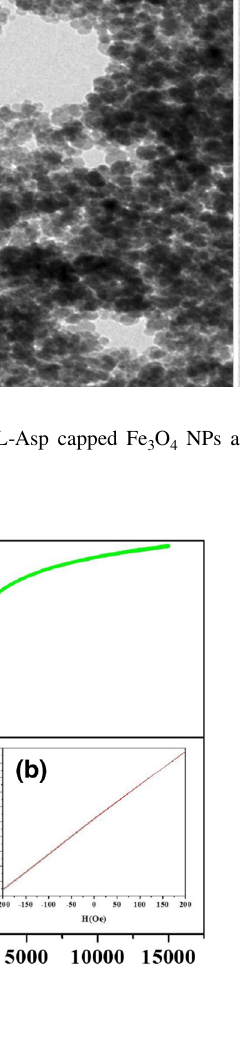
Fig. 6 a Magnetization value obtained from vibrating sample mag- netometer (VSM) and b inset: magnified view at low H(Oe) value of L-Asp capped Fe